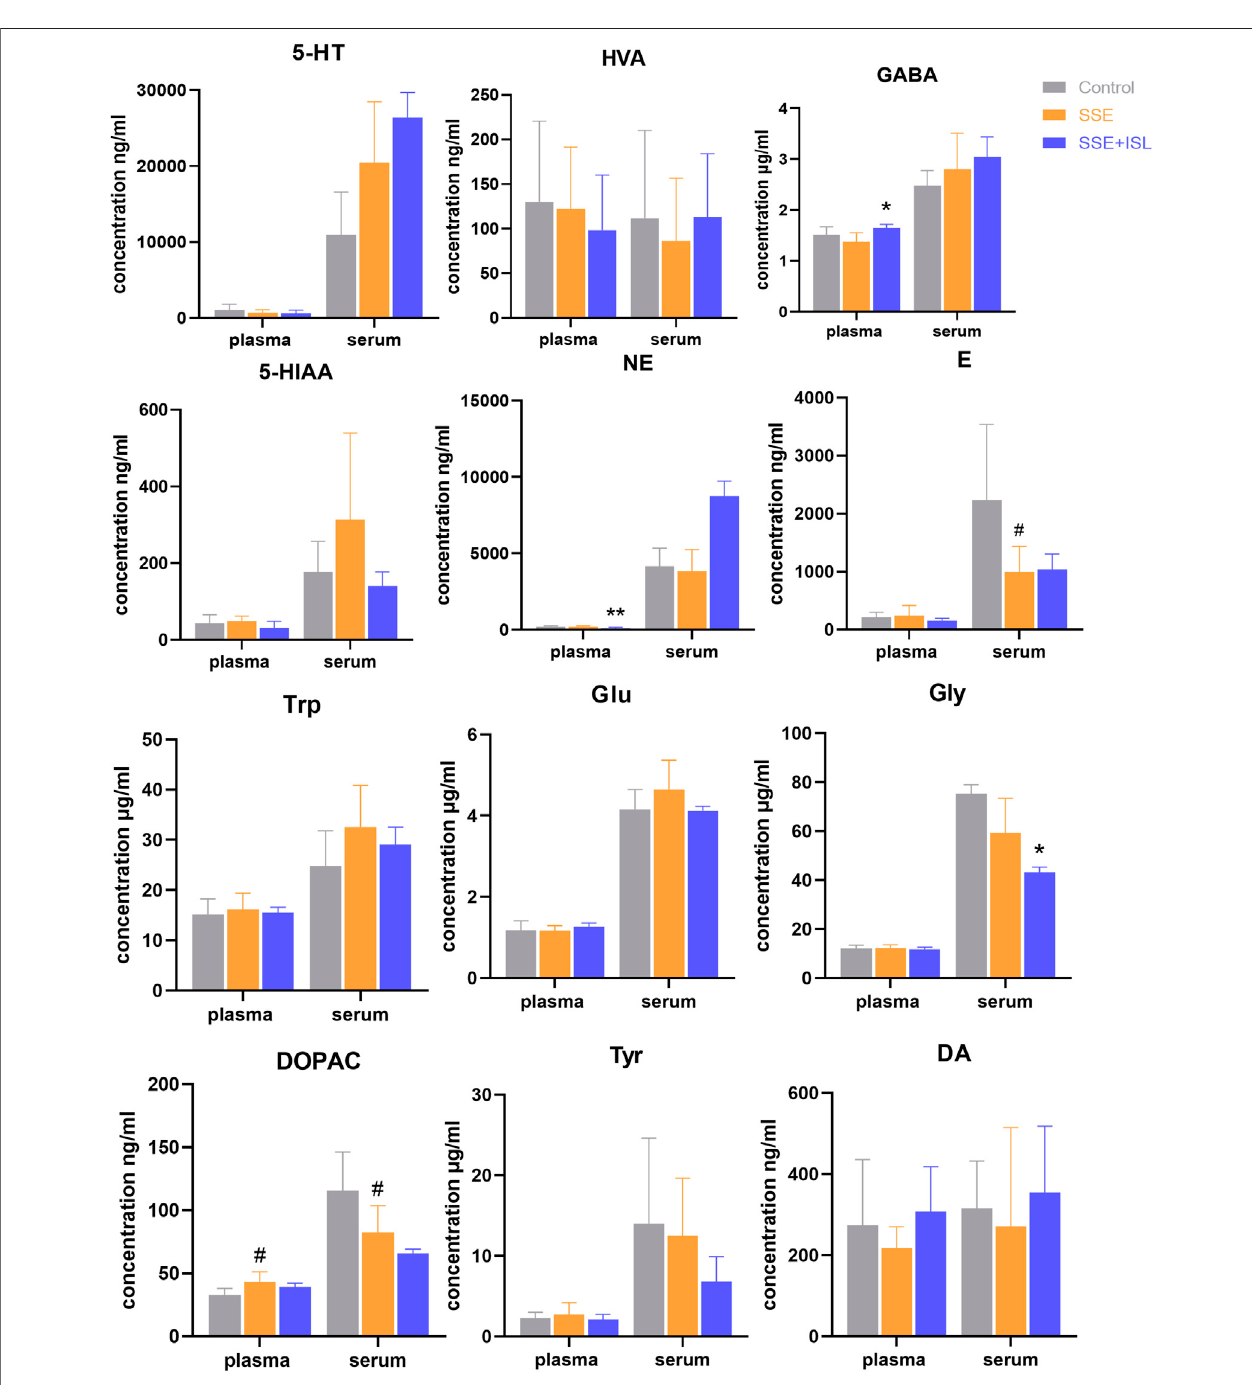
FIGURE4| Determinationsresultsofratbloodsamplesinplasmaandserumcollectedfromdifferentgroups.Eachvaluewasrepresentedasmean ± SD(standard deviation). ### p < 0.001, ## p < 0.01, and # p < 0.05 (SSE group vs. Control group); *** p < 0.001, ** p < 0.01, and * p < 0.05 (SSE + ISL group vs. SSE group).